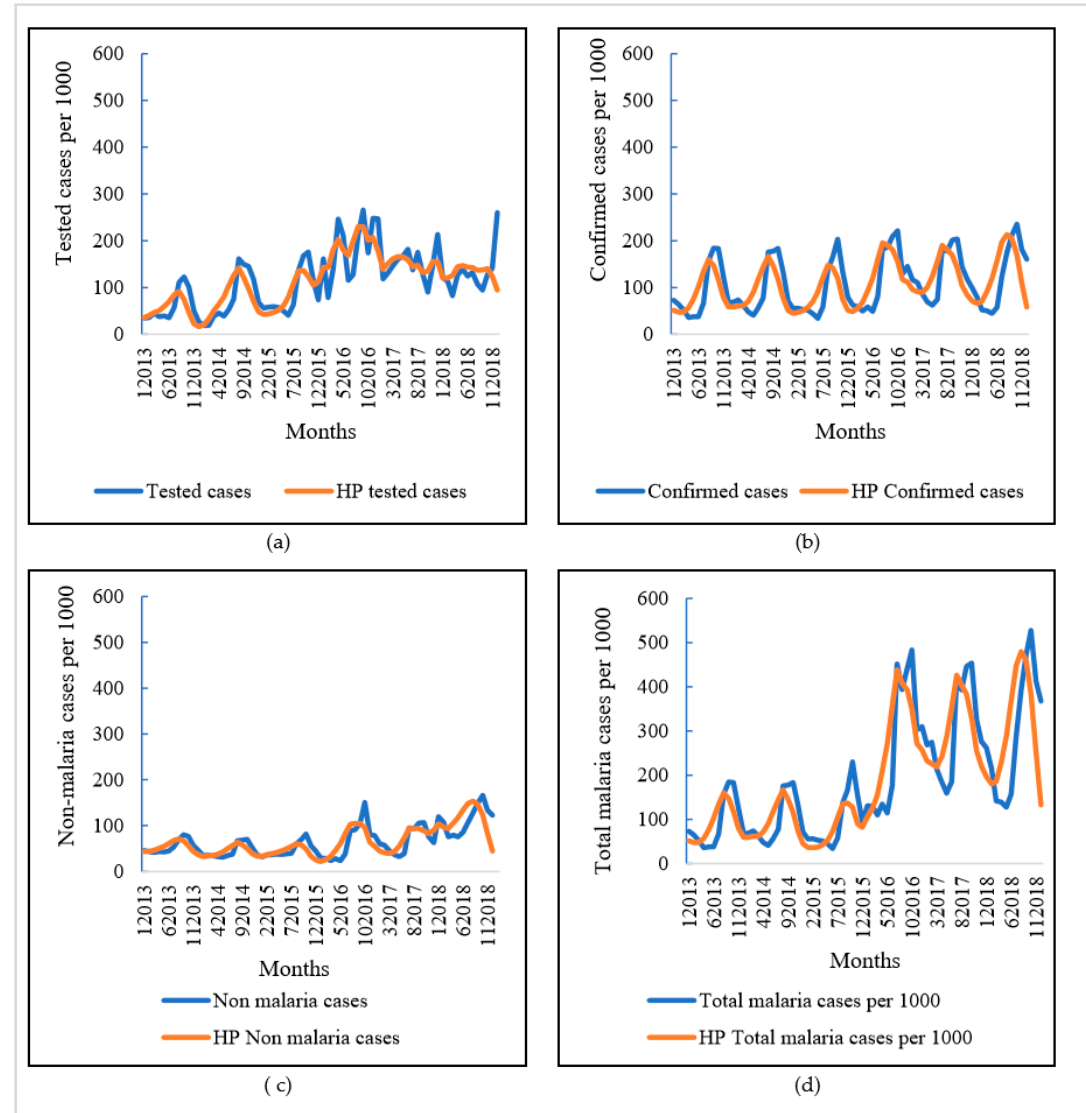
Figure 1. Trends of crude incidence of malaria reported cases over 72 months ( a ) tested incidence and ( b ) confirmed incidence ( c ) non-malaria cases, and ( d ) total cases. HP: Hodrick Prescott. The x-axis represents the time that combines both the month and the year. The last four digits represent the year and the first digits represent the month and ( a ) y: number of malaria tested cases per 1000 children under five ( b ) y: number of malaria confirmed cases per 1000 children under five ( c ) y: number of non-malaria cases per 1000 children under five ( d ) y: number of total malaria cases per 1000 children under five.